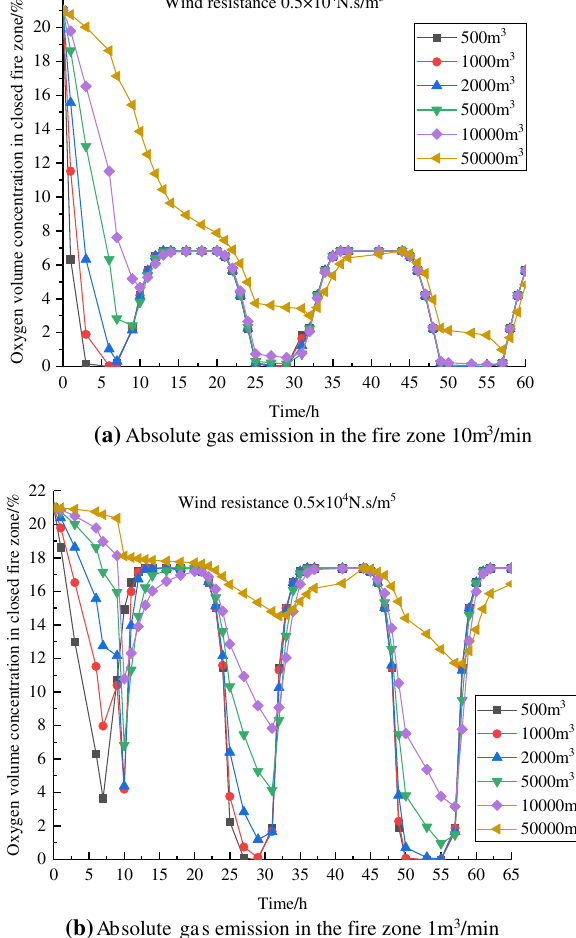
Fig. 6 The relationship between the gas emissions in different fire zone, the volume of different fire zone, and the small wind resistance is presented. The oxygen concentration in the fire zone changes with time after the completion of closure at